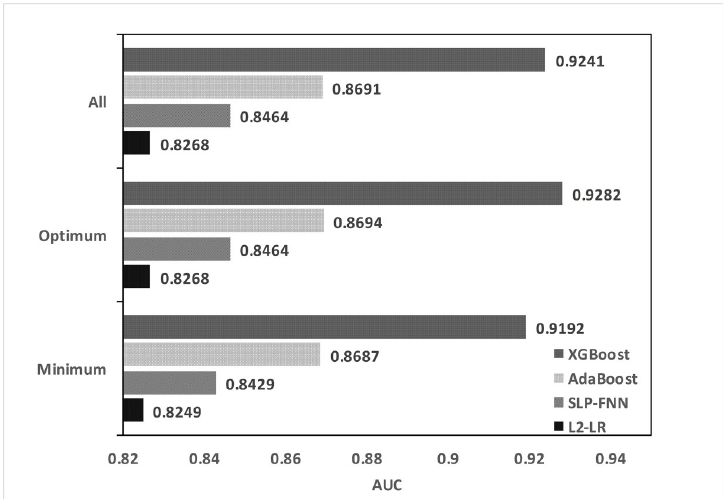
Fig 5. AUC of the four tested algorithms on the training set for different feature subsets. Based on the feature selection experiment, the training data set is used to study the recognition performance of four machine learning algorithms under different feature